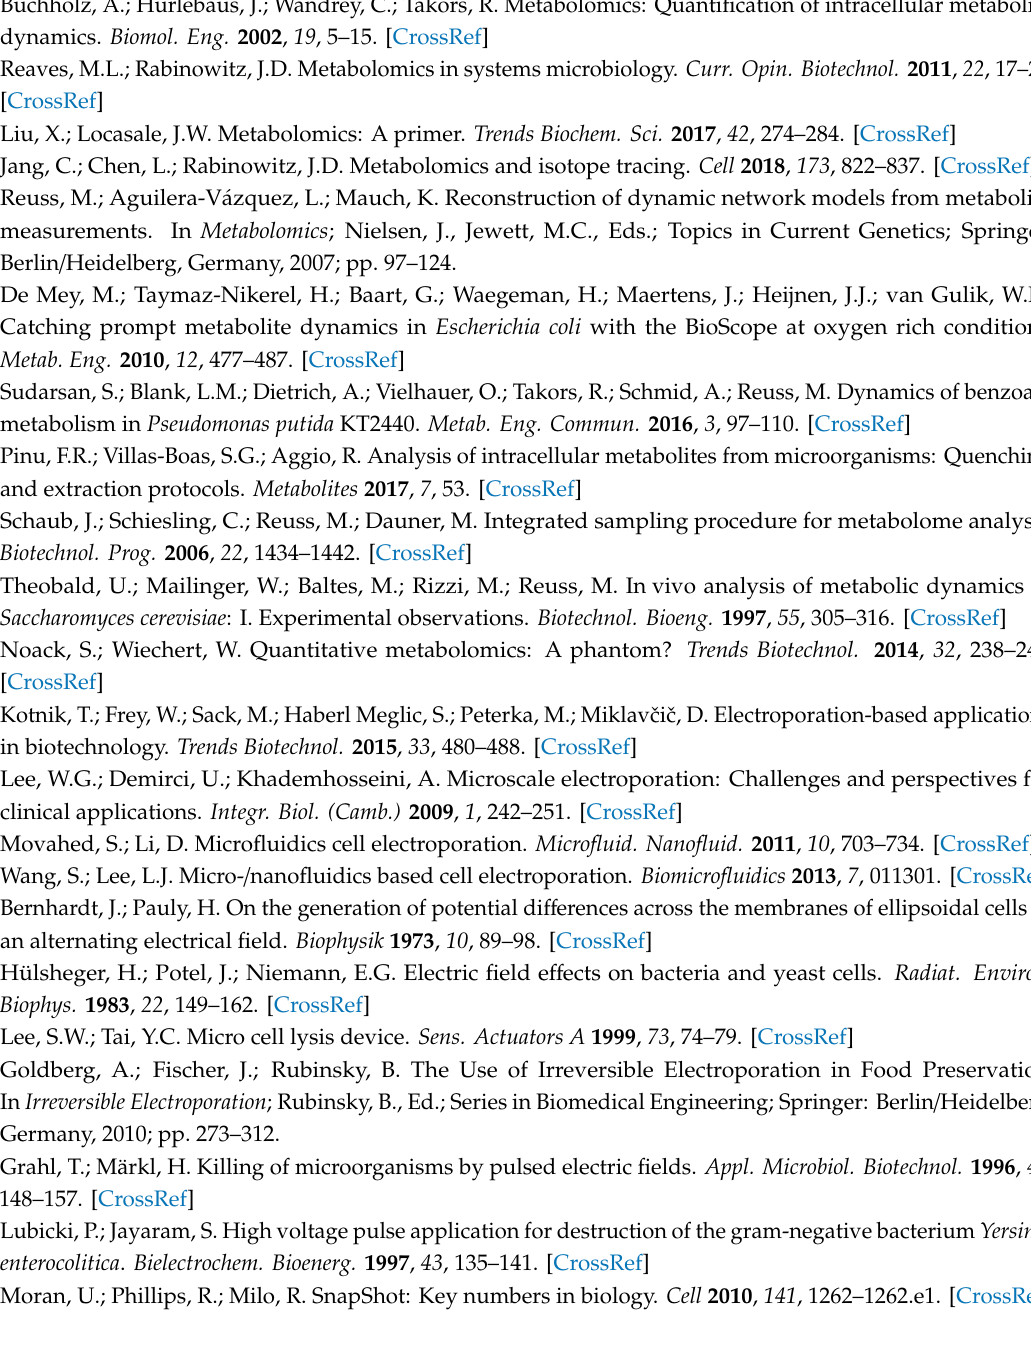
Figure S1: The influence of di ff erent applied electric field strengths on the viability of E. coli , Figure S2: The influence of di ff erent applied electric field strengths on the viability of S.